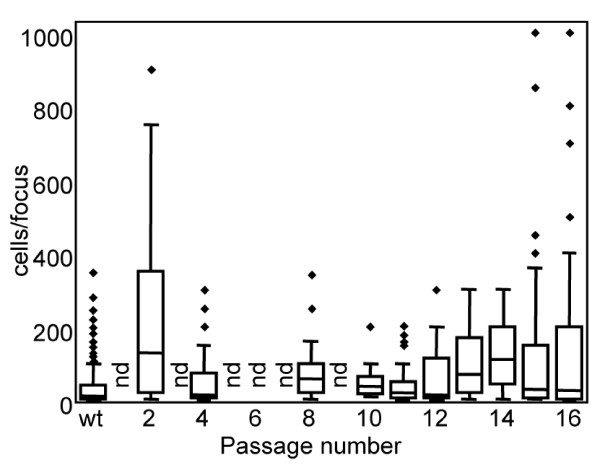
Infectious focus size varies greatly from passage to passage. Infectious foci of selected passages at limiting dilution were examined and the number of infected cells per focus were enumerated. (Median: horizontal line towards middle of box; 5th and 95th percentile values: lower and upper error bars, respectively; 25th and 75th percentile values: bottom and top of the box, respectively; outlier values: filled diamond; nd: not done). A minimum of 20 foci were examined for each passage. See Table 1 for pairwise statistical comparisons and numbers of foci analyzed. Data obtained for each passage were pooled from two to four independent experiments. Note that virus yield, degree of sensitivity of HA and infection to IgY, and focus size varied dramatically over the course of the study. Yield, antibody sensitivity, and focus size correlated poorly for individual passages.